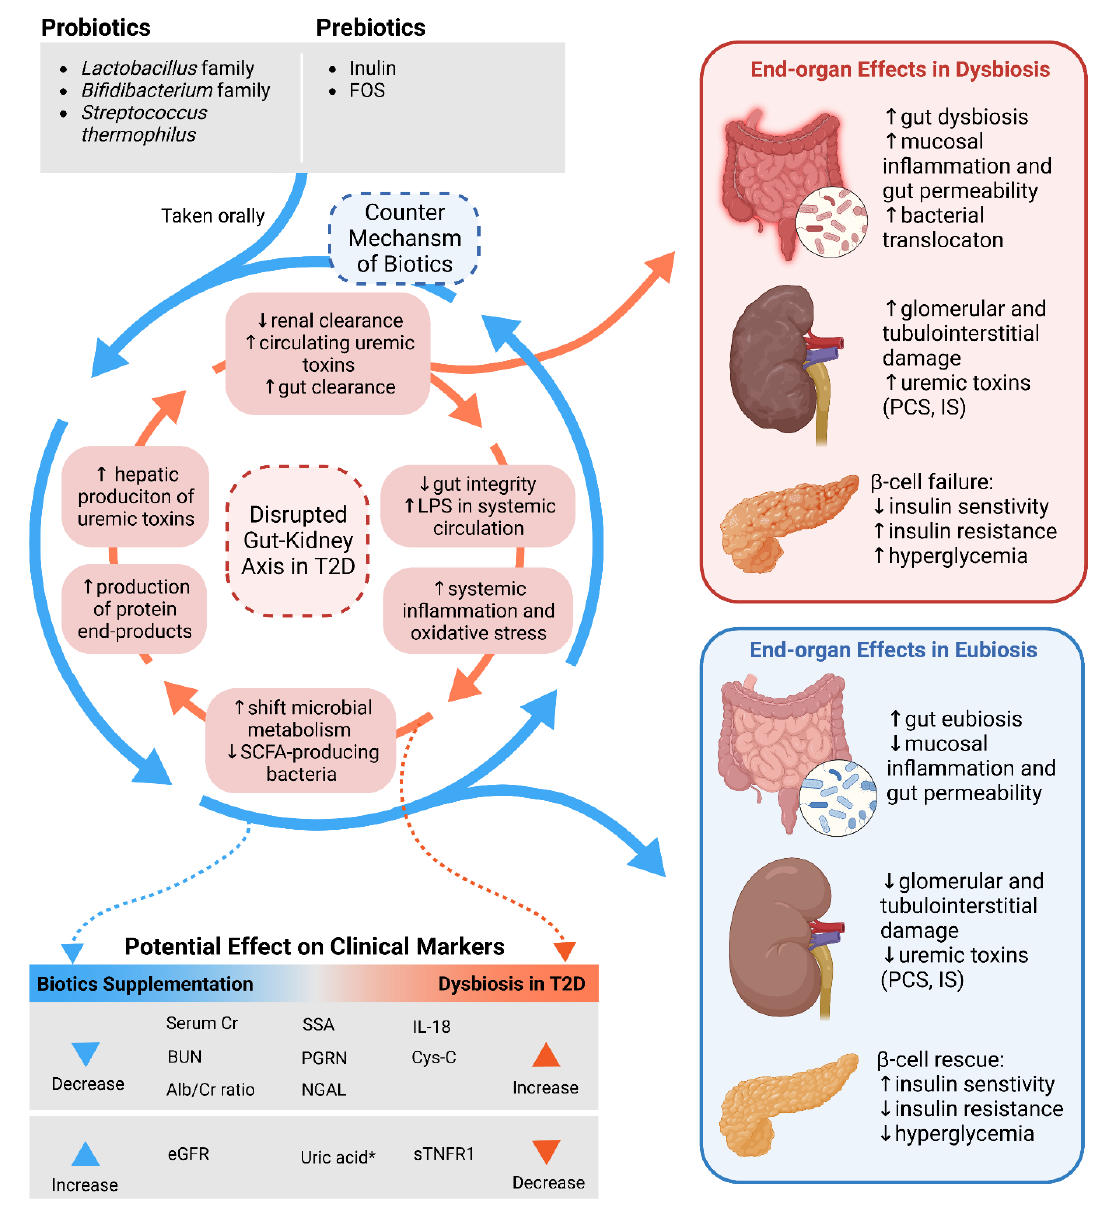
Figure 2. Schematic representing the disrupted gut–kidney axis in diabetes (in red) versus the potential counter mechanism (in blue) of biotic nutraceuticals (probiotics, prebiotics, and their combinations), in addition to their respective effects on end-organs and clinical (renal) biomarkers. Previously known as DN, DKD is defined as diabetes with microalbuminuria (Alb/Cr ratio ≥ 30 mg/g) and/or impaired eGFR (<6 0 mL/min/1.73 m 2 ). It develops in 30 – 40% of diabetics, and is the most prominent predictor of premature mortality in such patients [8,80]. It has been postulated that DKD is characterized by a multi-pathway pathogenesis based on hemodynamic, metabolic, and inflammatory changes [81]. Hemodynamically, there is increased efferent arteriolar vasoconstriction arising from activation of the renin – angiotensin – aldosterone system (RAAS) and subsequent increased angiotensin II levels